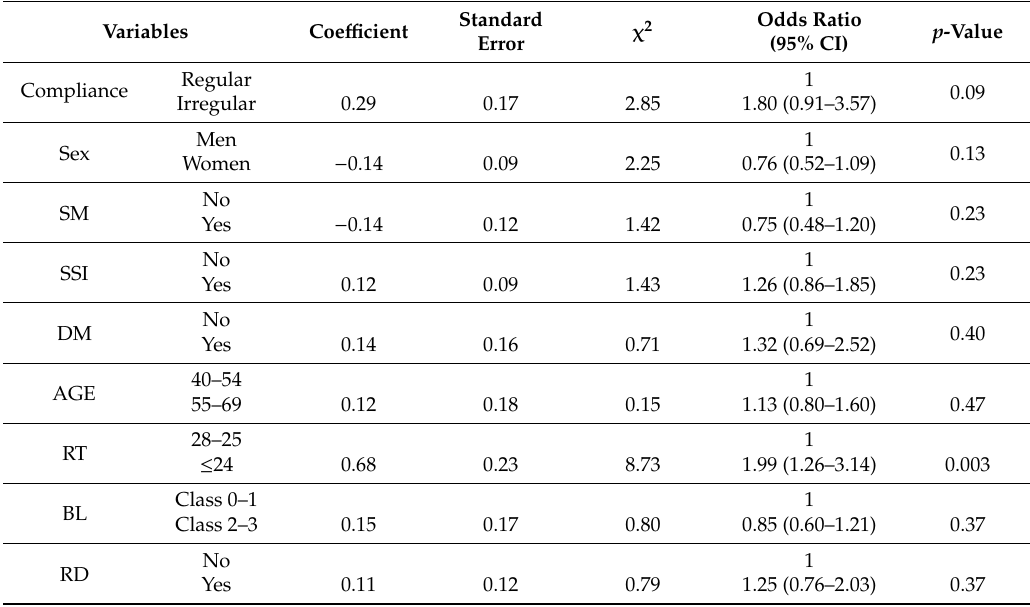
Table 5. Multiple logistic regression analyses of study variables with tooth